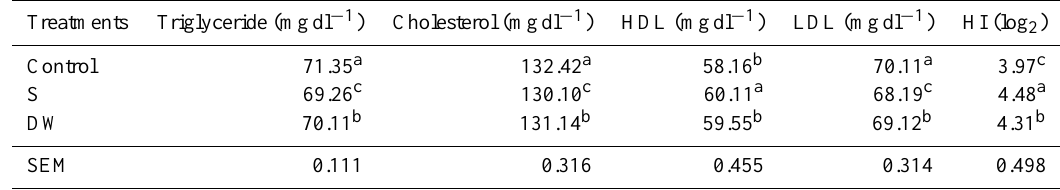
Table 4. The effect of sumac and whey powder diets on some blood biochemical parameters and antibody titer against Newcastle vaccine disease of female broiler chick.